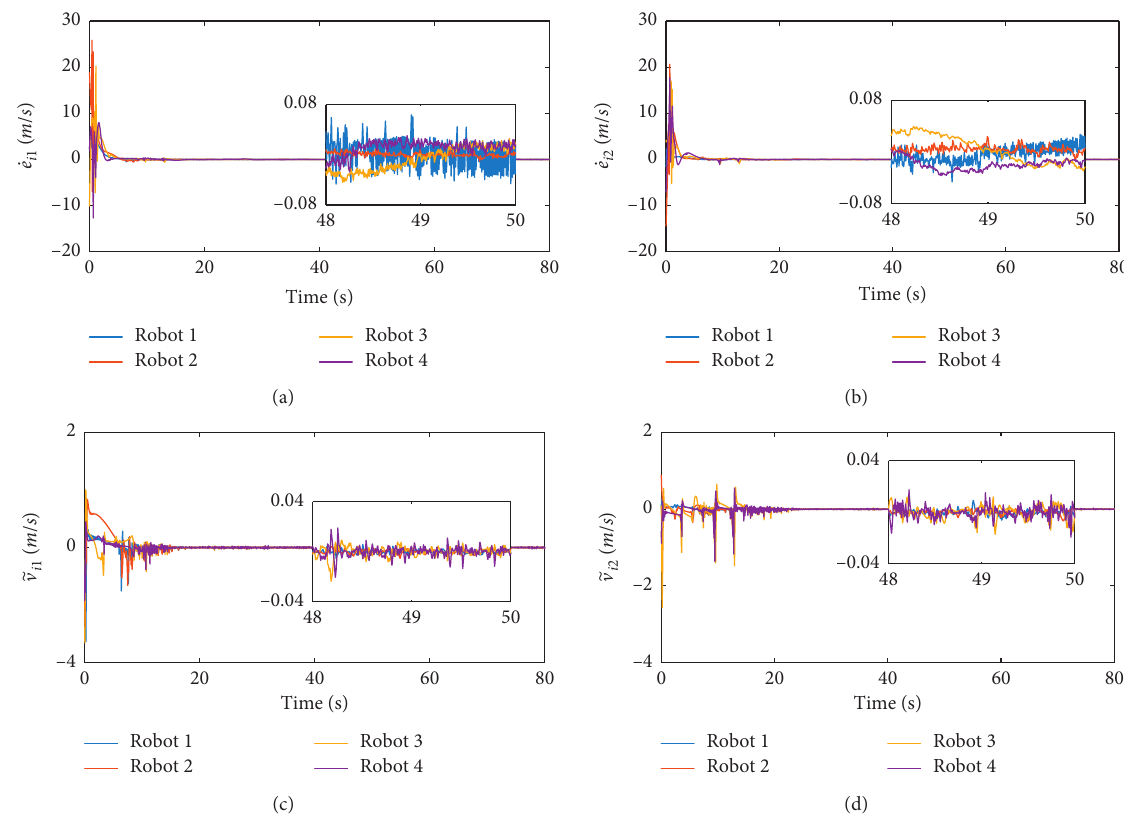
Figure 5: Evolution of _ e